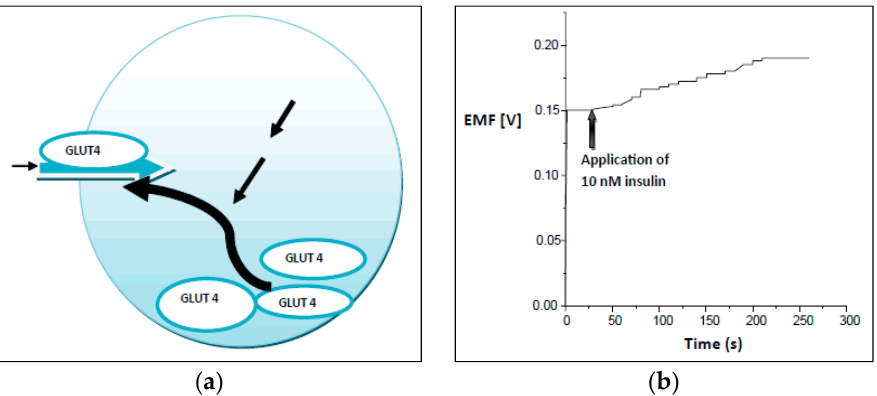
Figure 6. ( a ) Mechanism of the insulin-induced activation of the glucose uptake. ( b ) Impact of insulin induction in the extracellular solution on the output response curve during intracellular glucose sensing measurements [38].